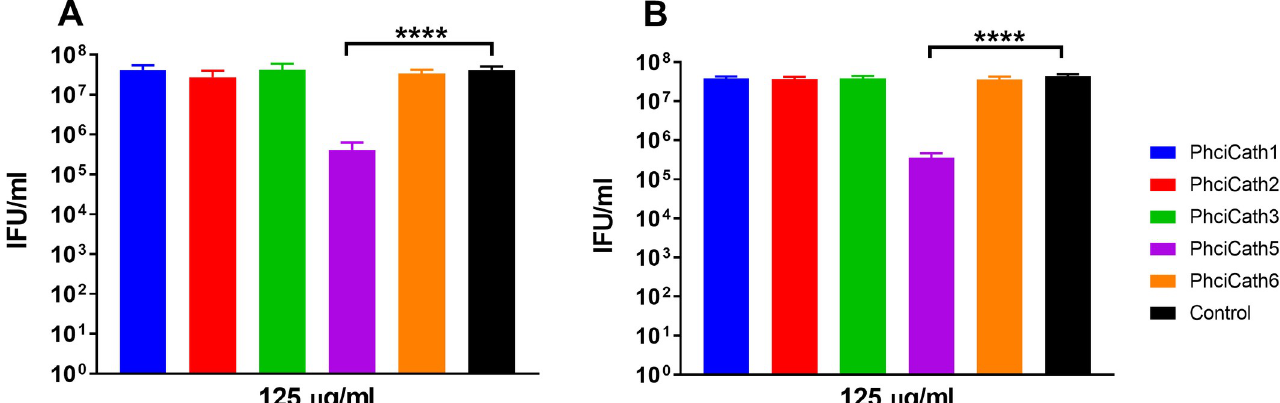
Fig 5. Activity of koala cathelicidins PhciCath1, 2, 3, 5 and 6 against C . pecorum MarsBar (A) and IPTaLE (B) at 125 μ g/mL. Expressed as inclusion forming units (IFU) per mL. Treatment of C . pecorum MarsBar and IPTaLE elementary bodies with 125 μ g/mL of PhciCath5 caused a significant decrease in infectious progeny in both serovars. PhciCath1, 2, 3 and 6 were ineffective against both serovars up to a concentration of 500ug/mL. ���� indicates p < 0.0001 significance was identified.